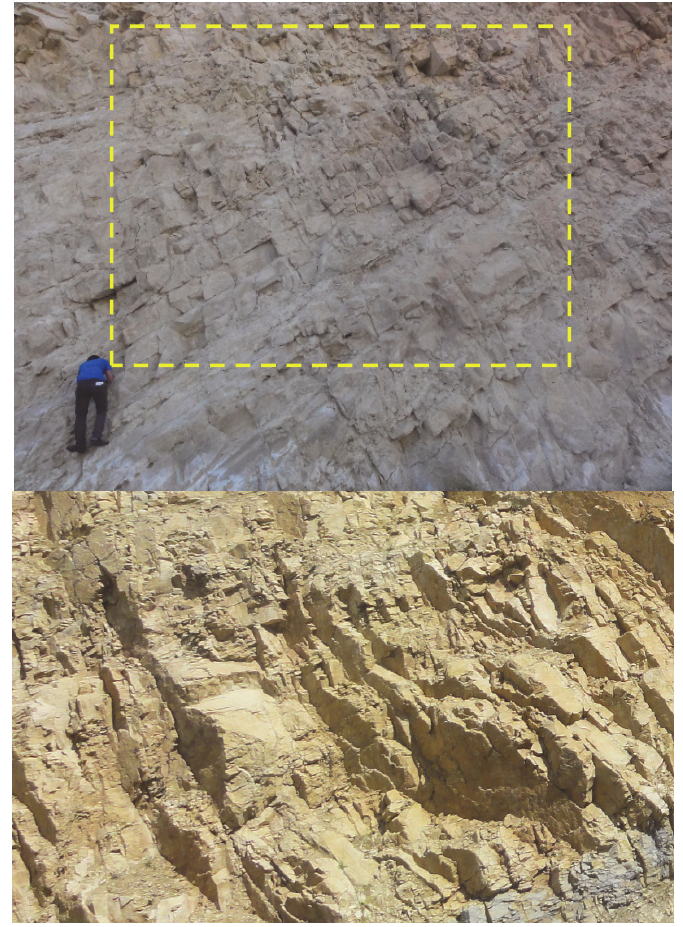
Figure 2: Two examples of limestone rock mass outcrops with